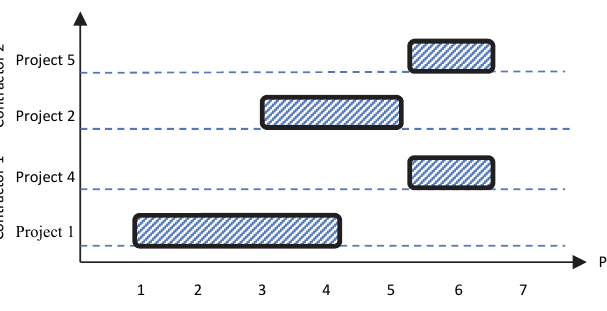
Fig. 1. Optimal scheduling of the project by contractors The objective function and their factors Optimal Objective